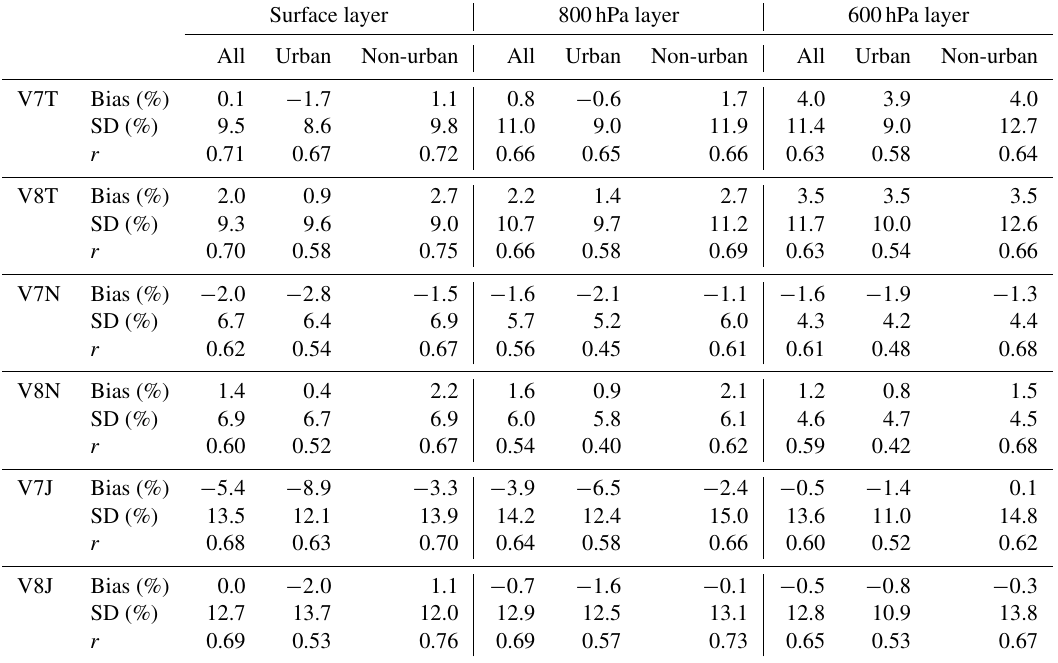
Table 2. Summarized validation results for V7 and V8 TIR-only (V7T and V8T), NIR-only (V7N and V8N) and TIR–NIR (V7J and V8J) products based on in situ profiles from DISCOVER-AQ, SEAC 4 RS, A-FORCE, KORUS-AQ, and